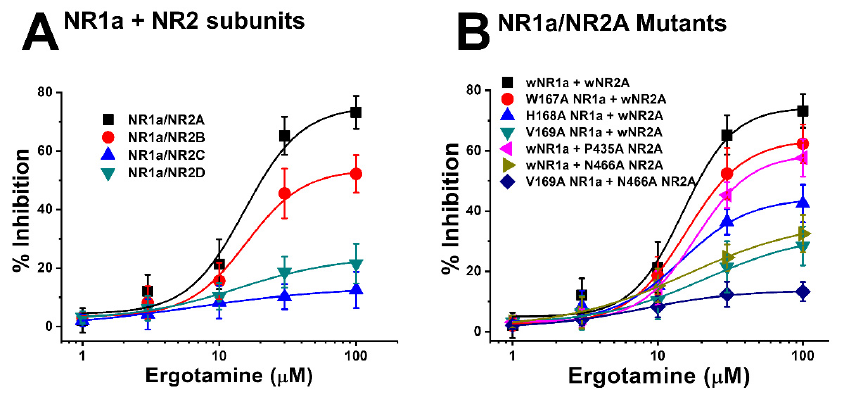
Figure 6. ( A ) Concentration-response curves for the effect of ergotamine on expressed NMDA receptors. The percentage inhibition by ergotamine was calculated based on the average of peak inward current elicited by glutamate and that of peak inward current elicited by glutamate and ergotamine. Each point represents the mean ± S.E.M. ( n = 6–8 oocytes from four different frogs). ( B ) Concentration–response curves for the inhibition of ergotamine on glutamate-induced inward current of NR1a/NR2A mutant types. NR1a (W167A, H168A, and V169A) and NR2A mutants (P435A and N466A) were cross-combined between wild-type/mutants of each subunit. Ergotamine reduced I Glu in a concentration-dependent manner in the wild-type. Experiments were performed at a holding potential of − 80 mV. The value of IC 50 , I max , and n H (Hill coefficient) are shown in Table 3. Each point represents the mean ±S.E.M. ( n = 6–8 oocytes from four different frogs).